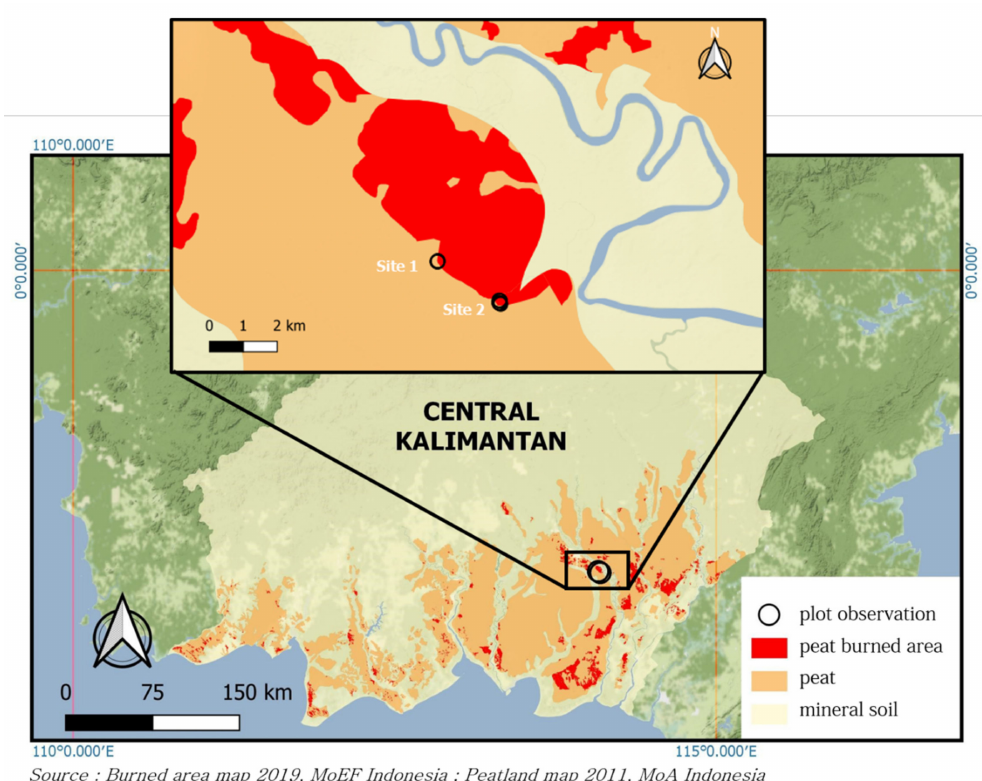
Figure 3. A map of the area burned in peat fires in 2019 in Central